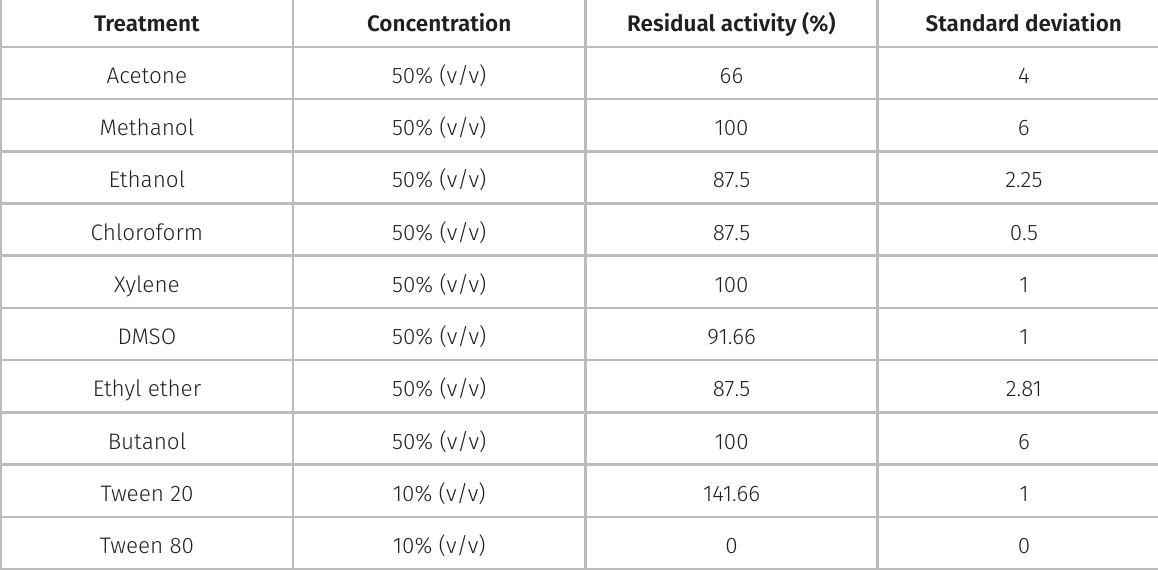
Table II. Effect of different chemicals and organic solvents on the antimicrobial activity of the partially purified crude supernatant produced by Bacillus sp. sed